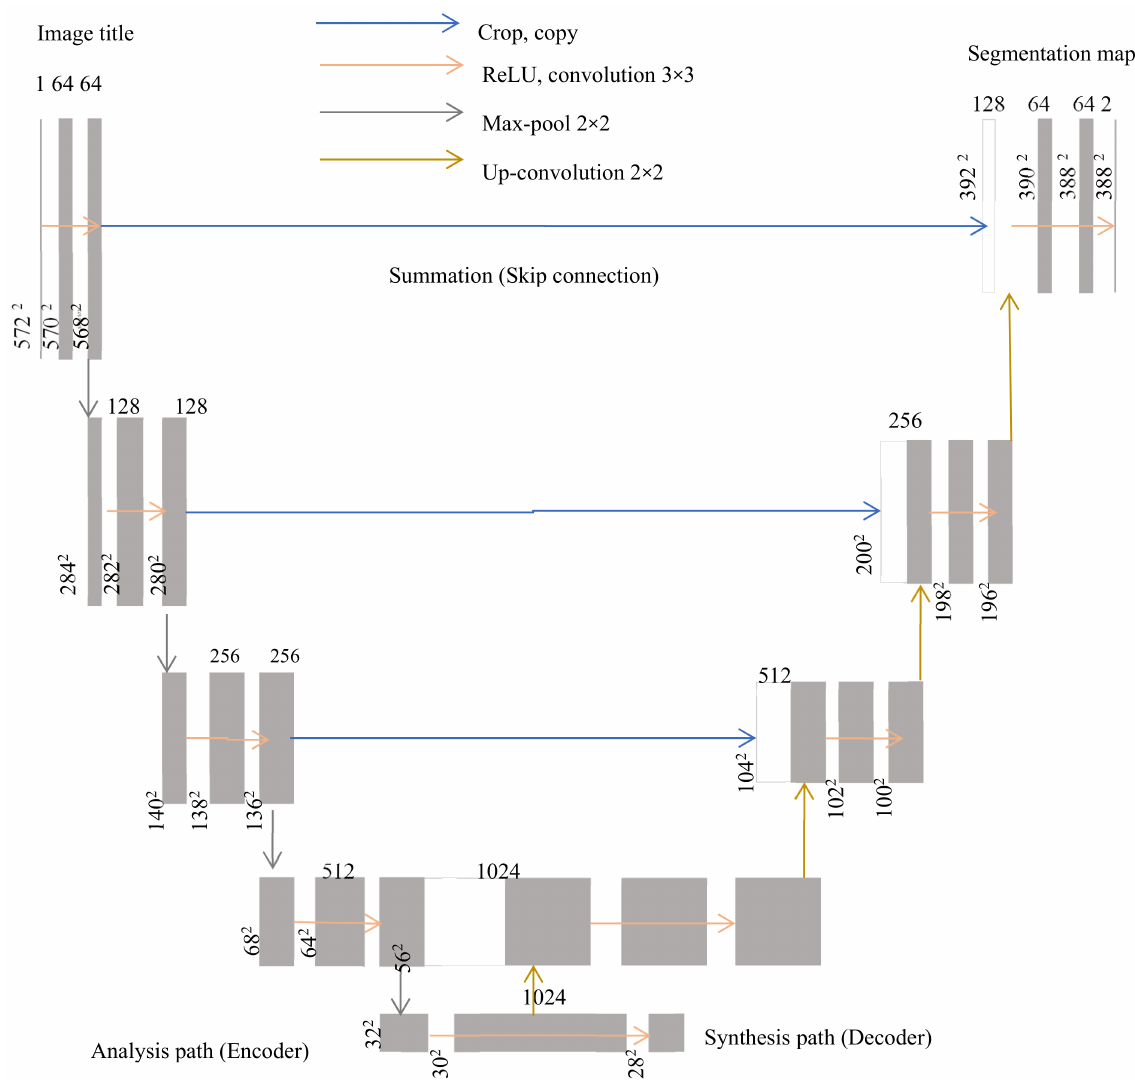
Figure 1. Architecture of